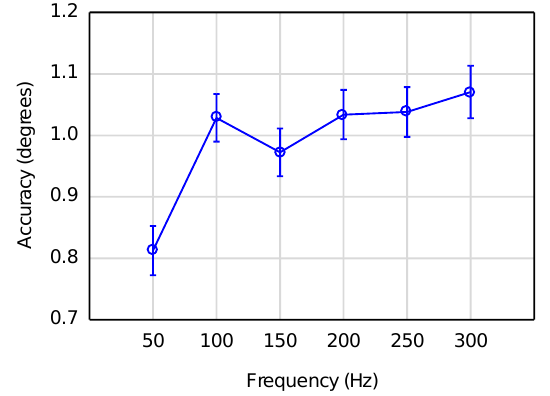
Figure 8: Average accuracy against sampling frequency. Vertical bars denote 95% confidence intervals.